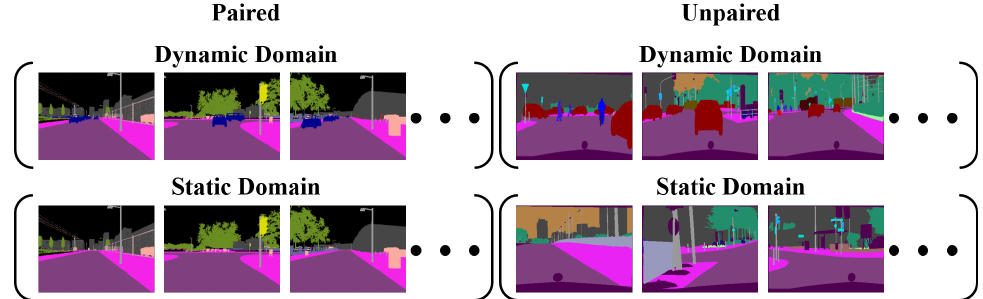
Figure 1. Paired static and dynamic maps for synthetic data ( left ). Unpaired static and dynamic maps for real-world data ( right ).